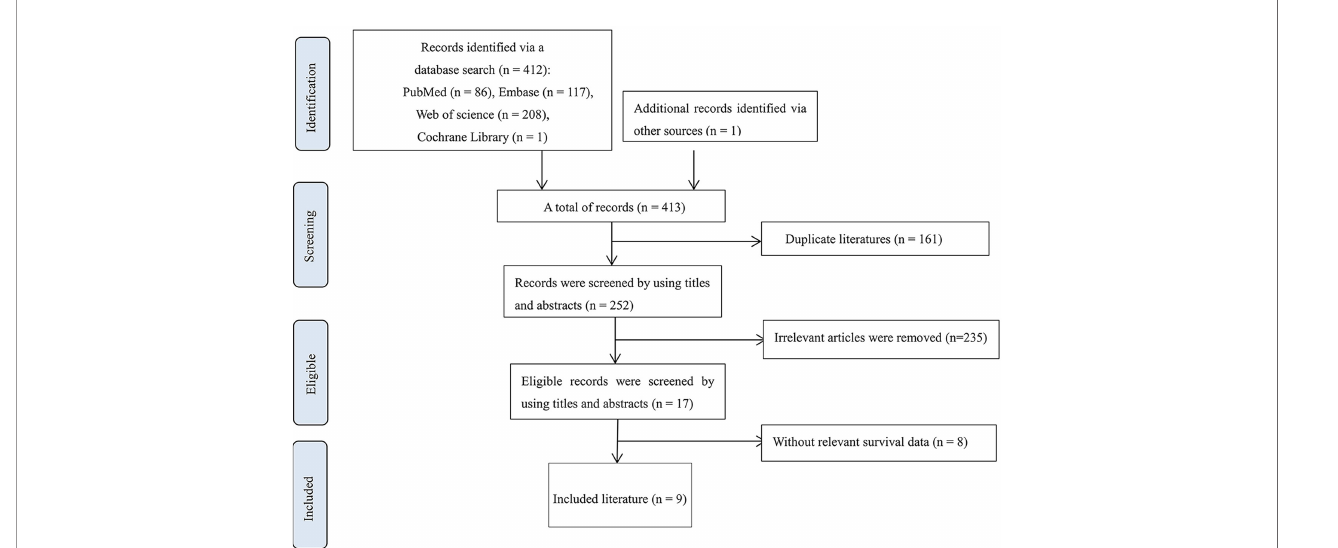
FIGURE 1 | Flowchart representing the systematic literature search on MSN and breast